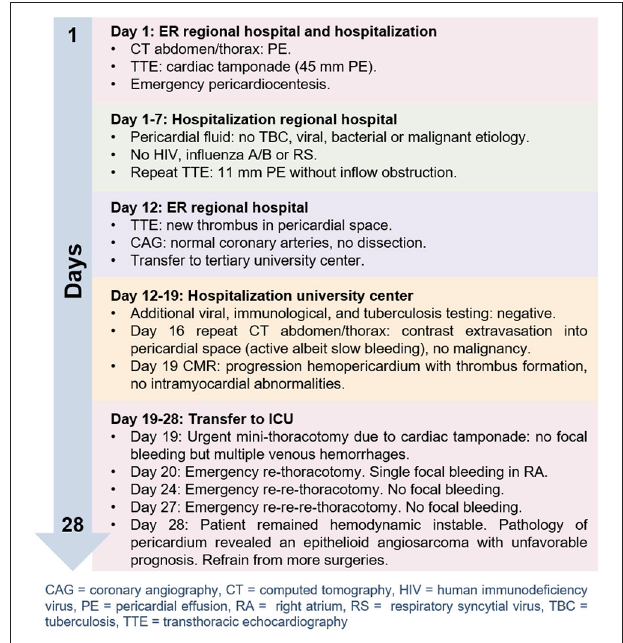
FIGURE 2 | Figure showcasing the timeline of